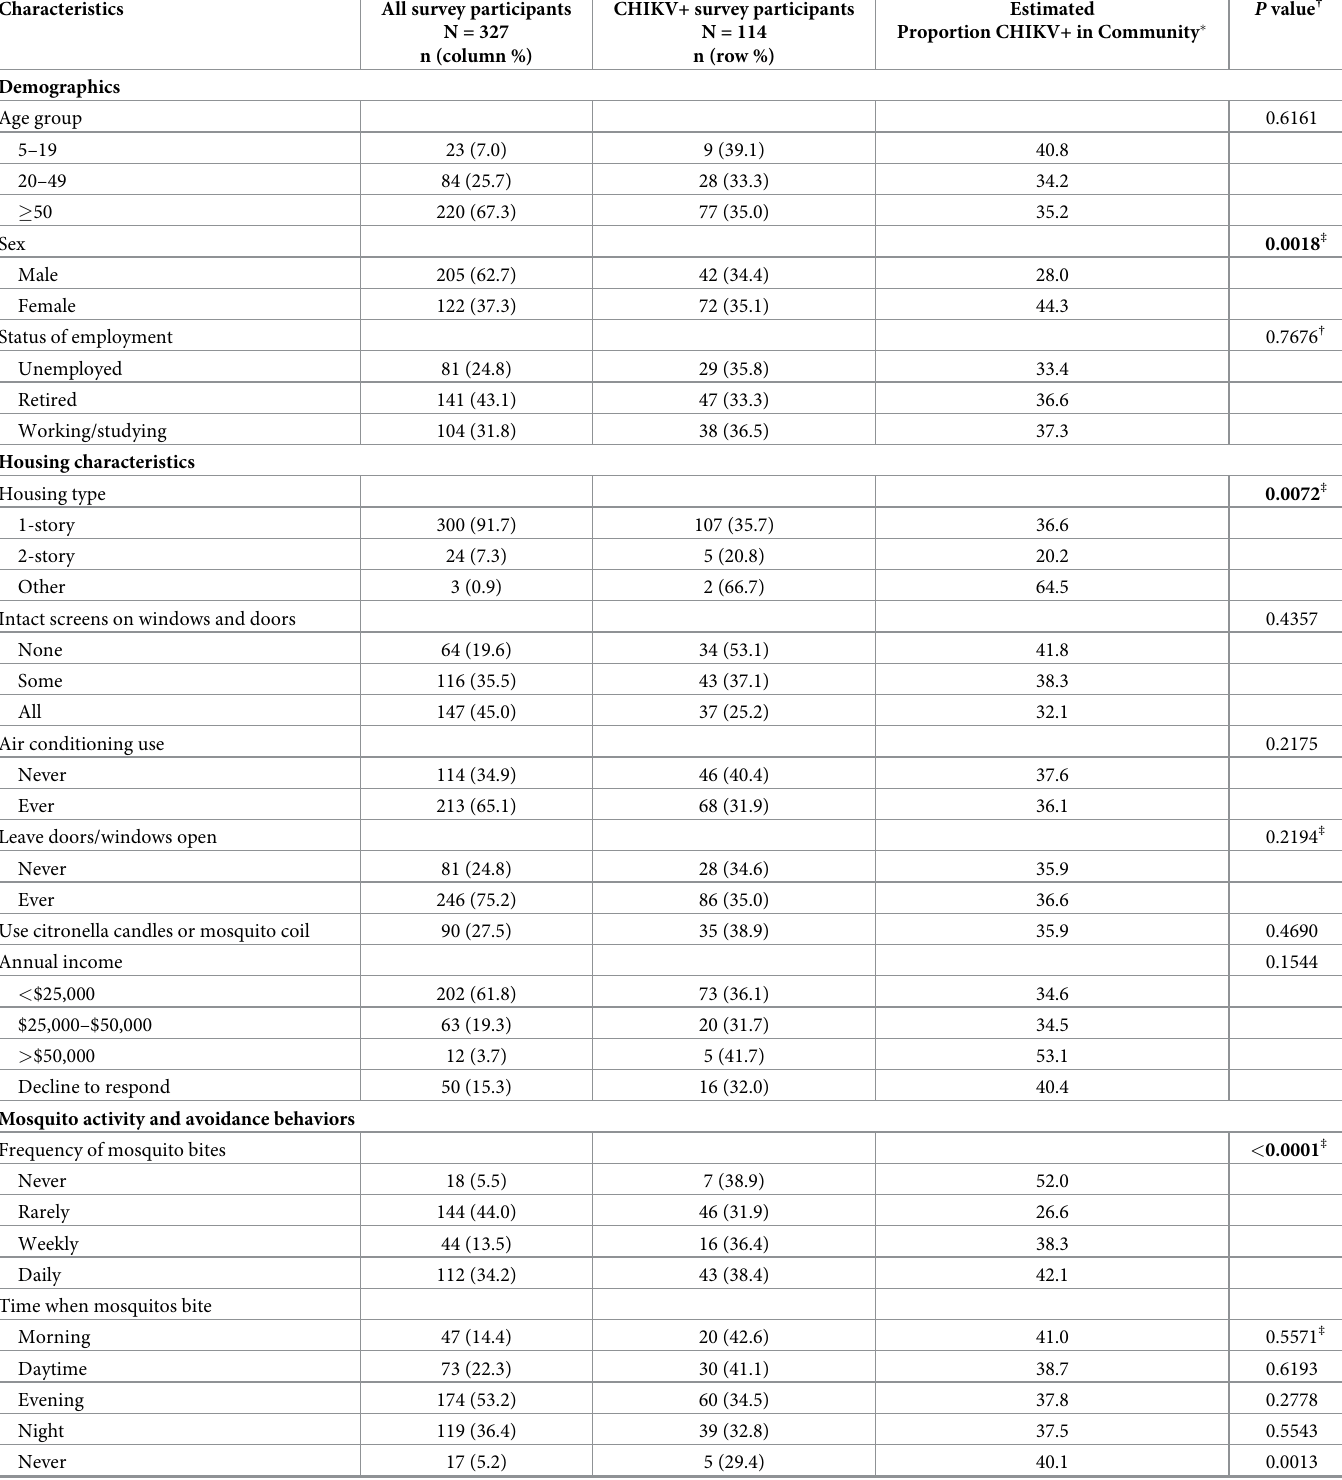
Table 3. Demographic and behavioral characteristics associated with chikungunya virus infection among survey participants from four communities in Puerto Rico, November 2015–February 2016.